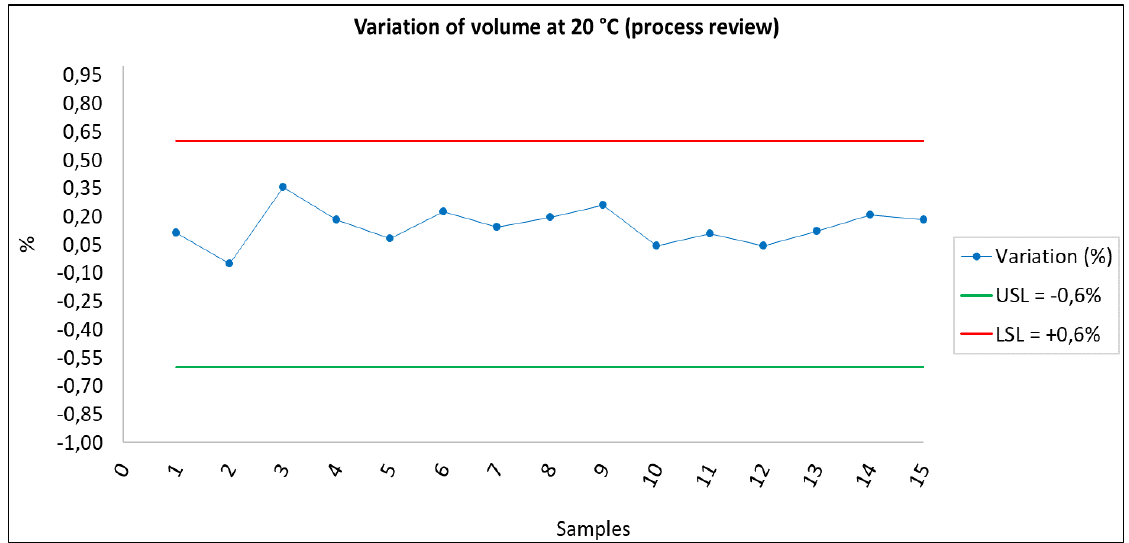
Figure 10: Graph of values and specification limits for Volume at 20 °C - process review. Source: Authors,